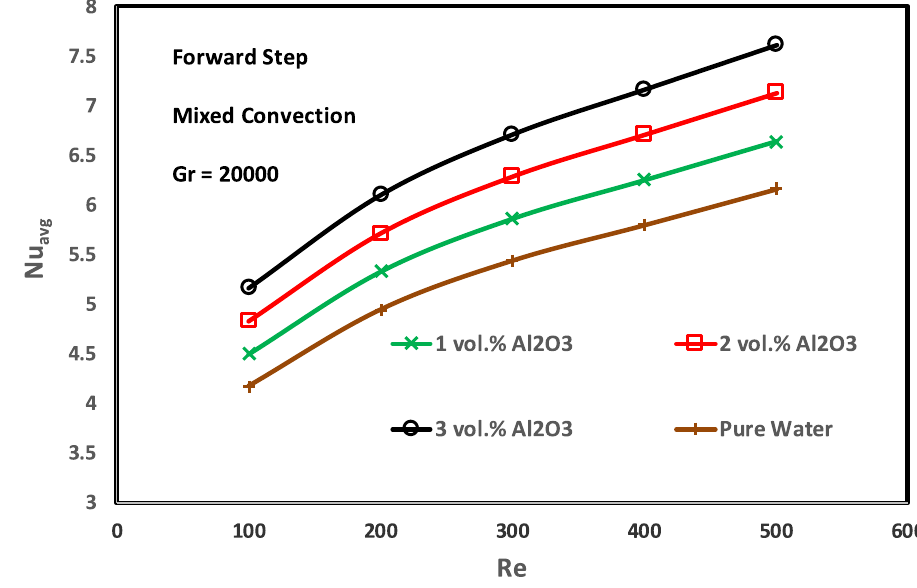
Fig. 9 Average Nusselt number values of different volume concentrations of nanofluid at different Reynolds number for forward step under mixed convection at Gr =